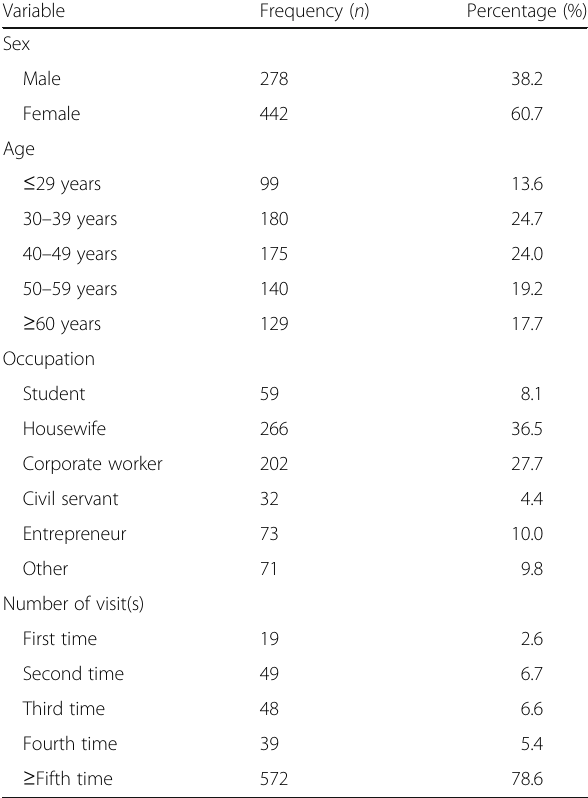
Table 1 Characteristics of survey participants ( n =